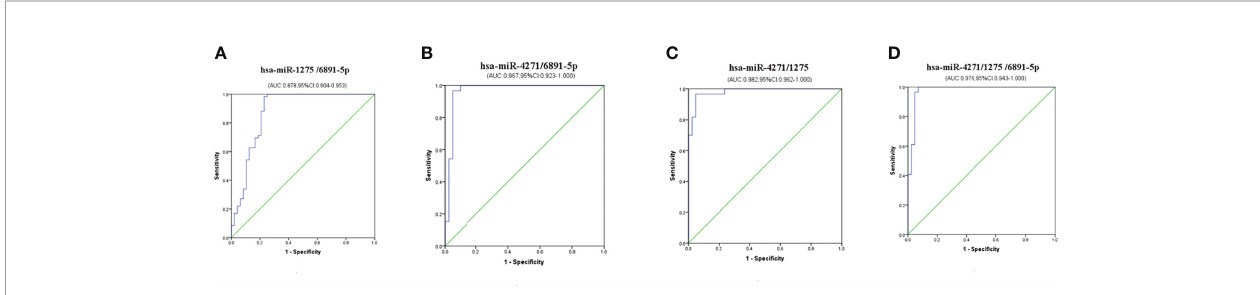
FIGURE 6 | Diagnostic utility of combined exosome miRNA levels in maternal serum in pregnant women with ICP. (A) hsa-miR-1275/6891-5p; (B) hsa-miR-4271/ 6891-5p; (C) hsa-miR-4271/1275; (D)